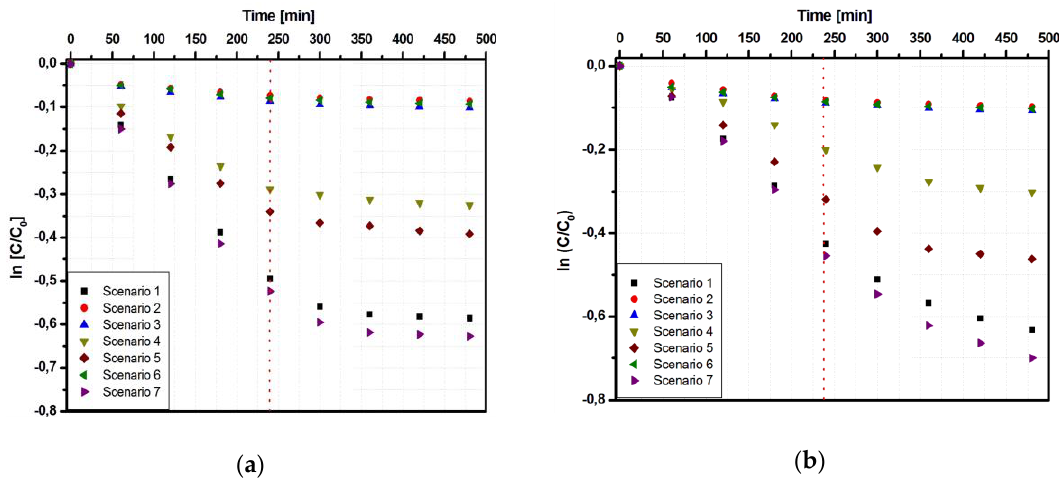
Figure 6. Kinetic data of the Ti_G sample using the Langmuir–Hinshelwood correlation: ( a ) Tr and ( b ) Apd photodegradation.